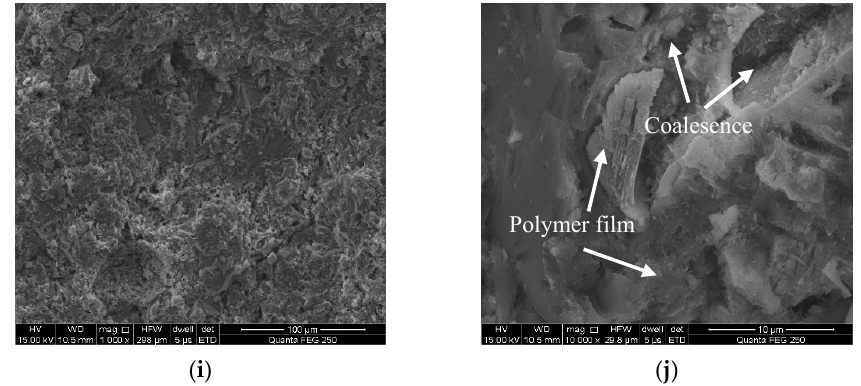
Figure 23. Microstructure of different pastes cured for 3 d. ( a ) Cement paste (Magnified 2000 times), ( b ) Cement paste (Magnified 10,000 times), ( c ) C-L6(Magnified 2000 times), ( d ) C-L6(Magnified 10,000 times), ( e ) C-R1.0(Magnified 2000 times), ( f ) C-R1.0 (Magnified 10,000 times), ( g ) C-H0.075 (Magnified 2000 times), ( h ) C-H0.075 (Magnified 10,000 times), ( i ) C-L6-R1.0-H0.035 (Magnified 2000 times), ( j ) C-L6-R1.0-H0.035 (Magnified 10,000 times).